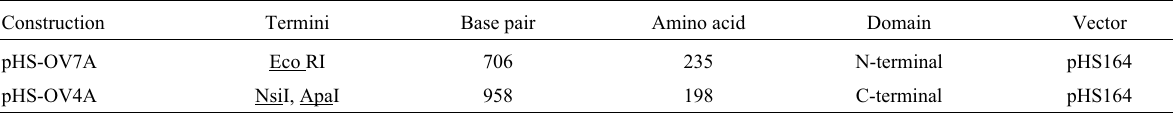
Table I - Summary for subcloning in